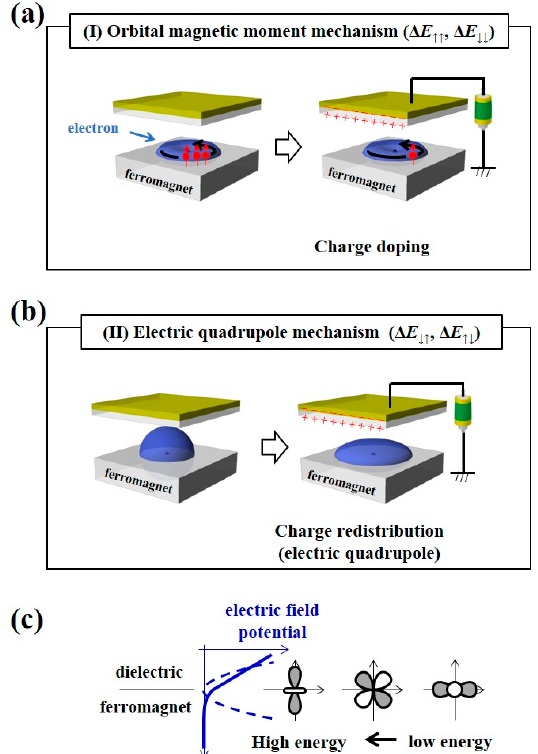
Figure 6. Microscopic origin of the VCMA effect. ( a ) Orbital magnetic moment mechanism. ( b ) Electric quadrupole mechanism. ( c ) Schematic of the nonlinear electric field at the interface between the dielectrics and the ferromagnet, which induces a charge redistribution-induced VCMA effect.